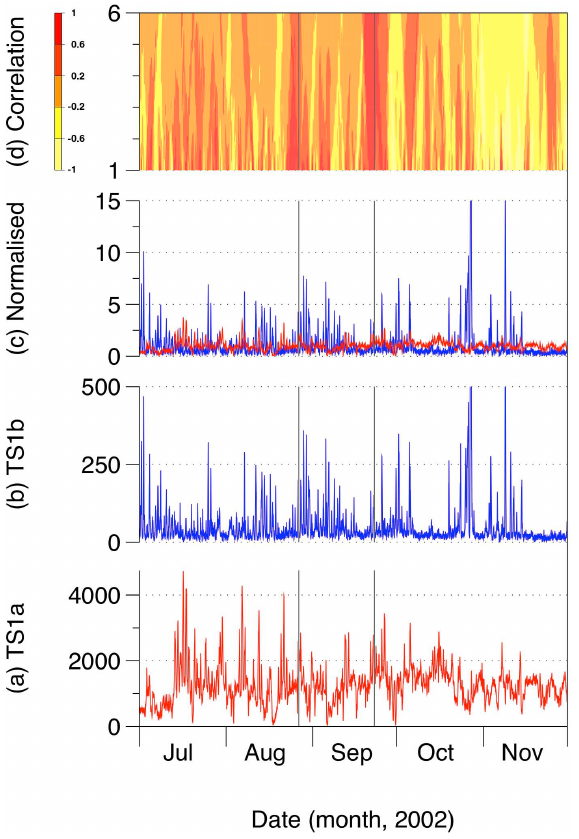
Fig. 1. Radon Time-Series, July–November 2002; (a) TS1a (red) hourly data, (b) TS1b (blue) hourly data, (c) TS1a (red) and TS1b (blue) normalised hourly data, (d) rolling/sliding windowed cross- correlation 1–6 day windows. The vertical grey lines show the main earthquake timings.